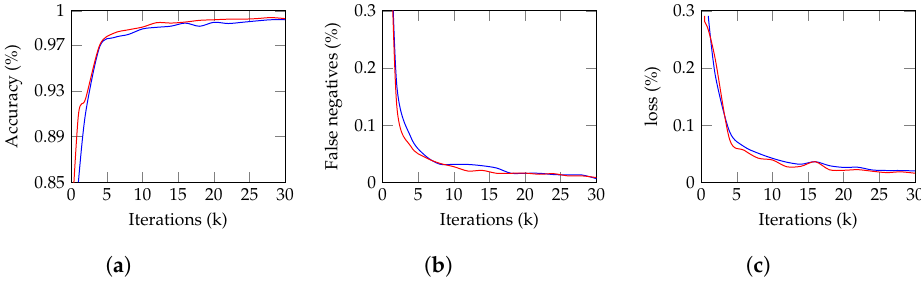
Figure 6. Faster R-CNN (R50-FPN) in red and Mask R-CNN (R50-FPN) in blue over 30k iterations. ( a ) Illustrates accuracy, with Mask R-CNN (R50-FPN) having a higher overall accuracy of 99.34%. ( b ) Compares false negative rate, with Mask R-CNN (R50-FPN) performing better with a final false negative rate of 0.8%. ( c ) Demonstrates convergence of loss value, with Faster R-CNN (R50-FPN) demonstrating faster convergence and a lower minimum loss